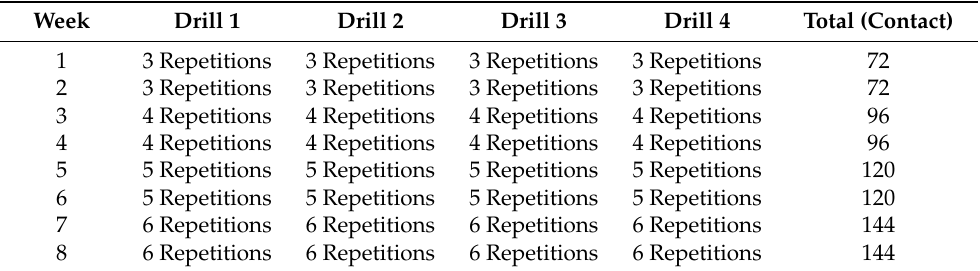
Table 2. Plyometric components were introduced into the program of the experimental